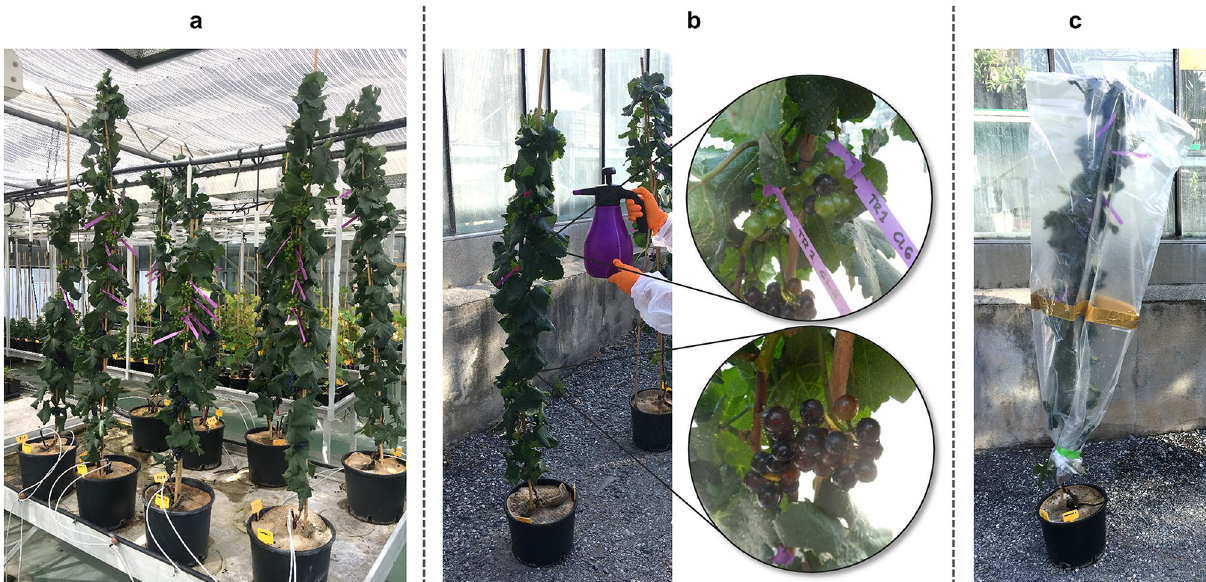
Figure 8. Experimental setup. ( a ) Microvine plants in the greenhouse; ( b ) ozonated water spraying treatment on plants showing different berry developmental stages; ( c ) microvine covered with a plastic bag immediately after the